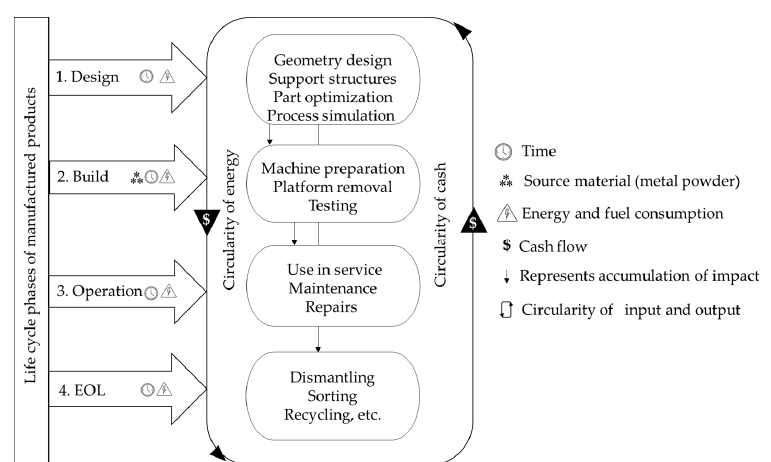
Figure 10. Representation of the LCC model for products made with L-PBF showing interrelations between phases based on time, energy, metal powder, and cash flow.